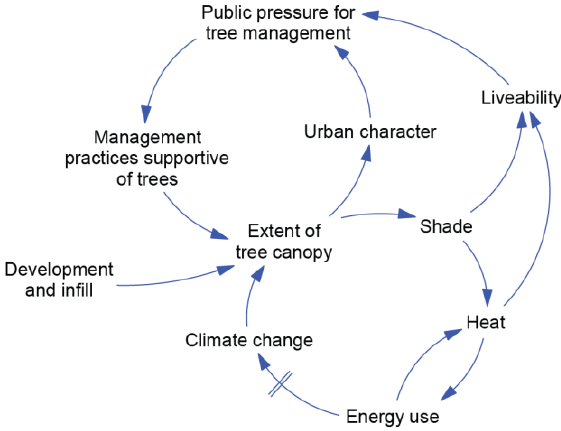
Figure 5. Planning and Environment Sector Influence Diagram.